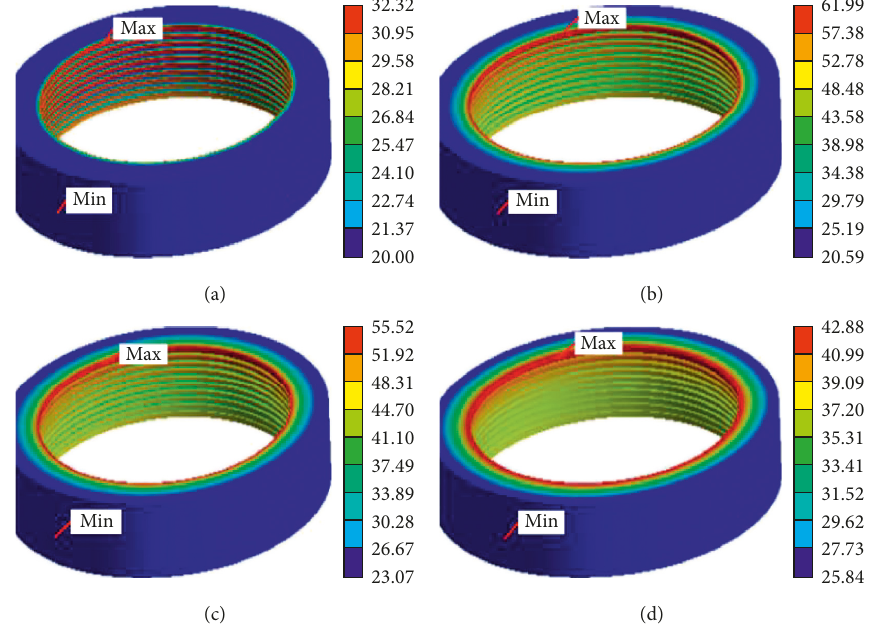
Figure 9: Surface temperature distribution of the synchronous ring. (a) t